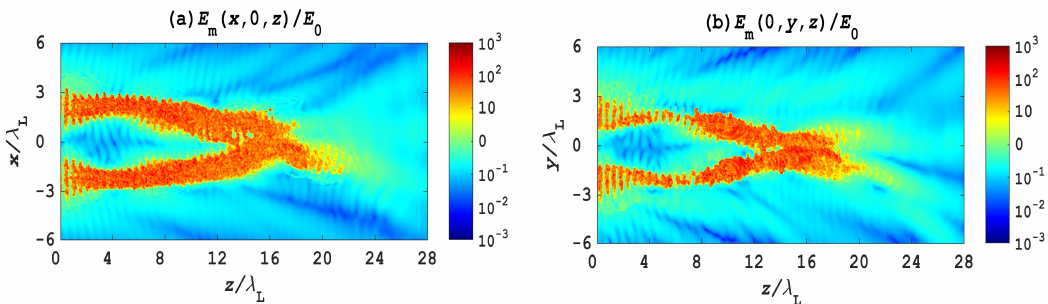
LG laser laser beam 0 0